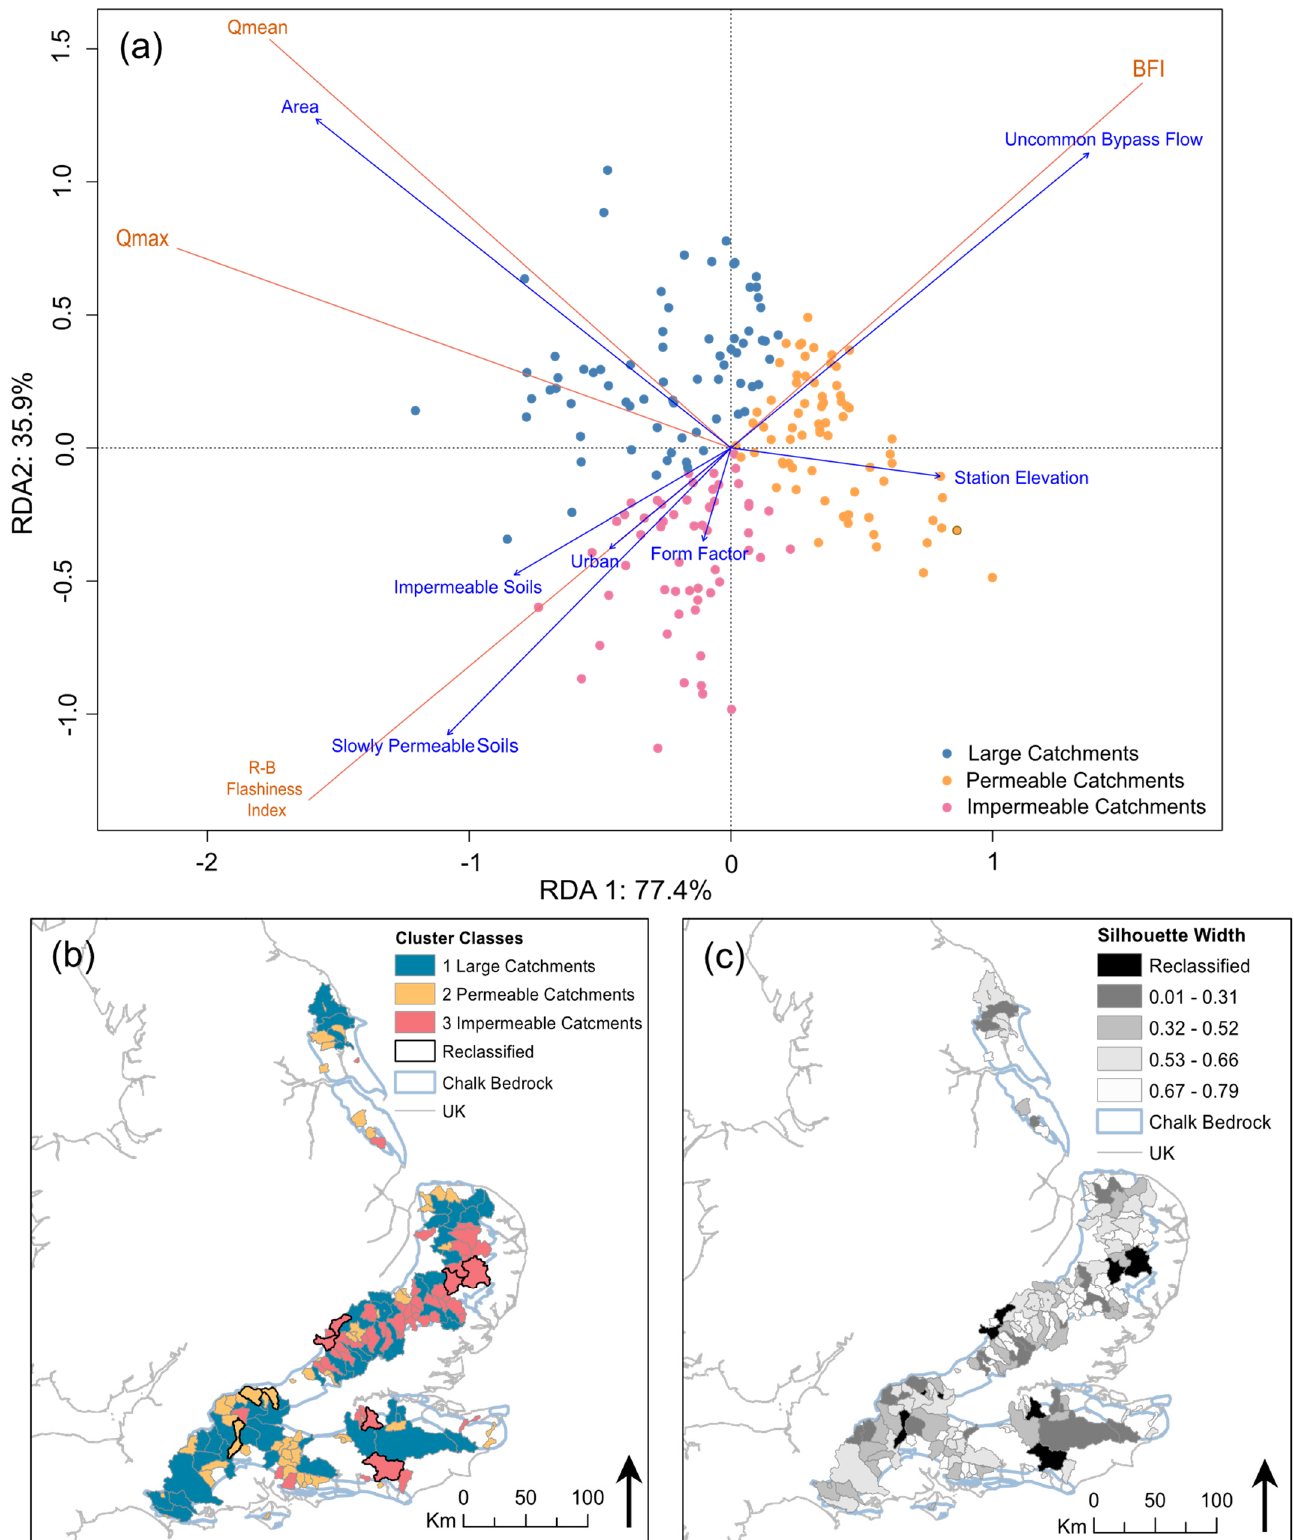
Figure 4. ( a ) Biplot showing catchment locations along two RDA axes. Dark orange vectors represent hydrological variables, and blue vectors are the catchment properties, with points for catchments placed relative to the vectors based on their individual values for catchment properties. ( b ) The catchment classifications mapped spatially. Misclassified catchments are presented in their reclassified grouping and outlined in bold. ( c ) The uncertainty of catchment classification according to silhouette widths. Misclassified catchments (<0) were reclassified into their nearest neighbour alternative classification.